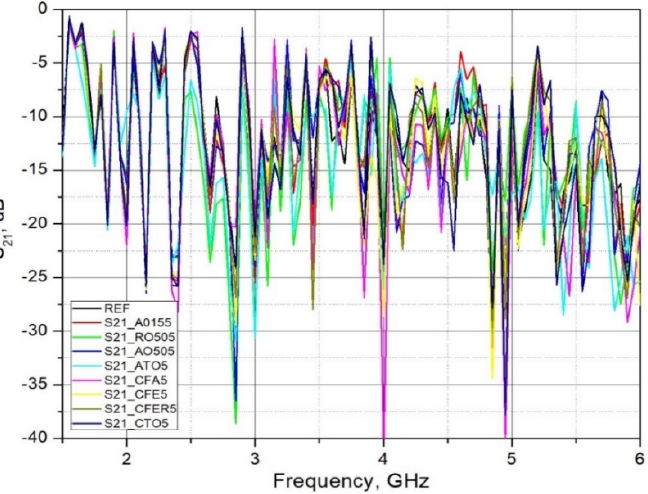
Figure 7 . S 21 measured and simulated results of brick sample in a frequency range 1.5 to 6 GHz, (d = 18 mm; 2r = 150 mm) .